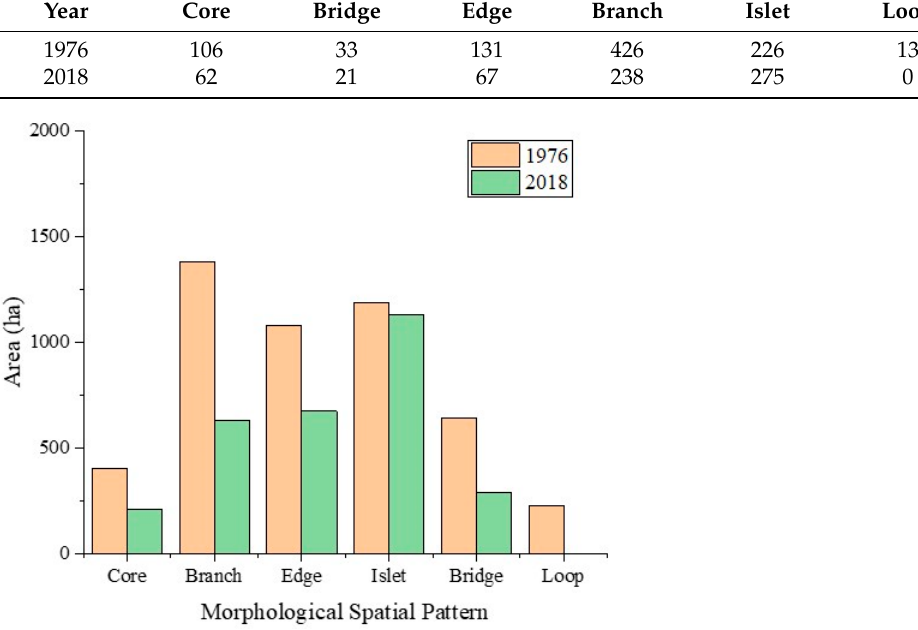
Figure 10. The areas of different morphological spatial pattern classes of historical forests in 1976 and 2018.